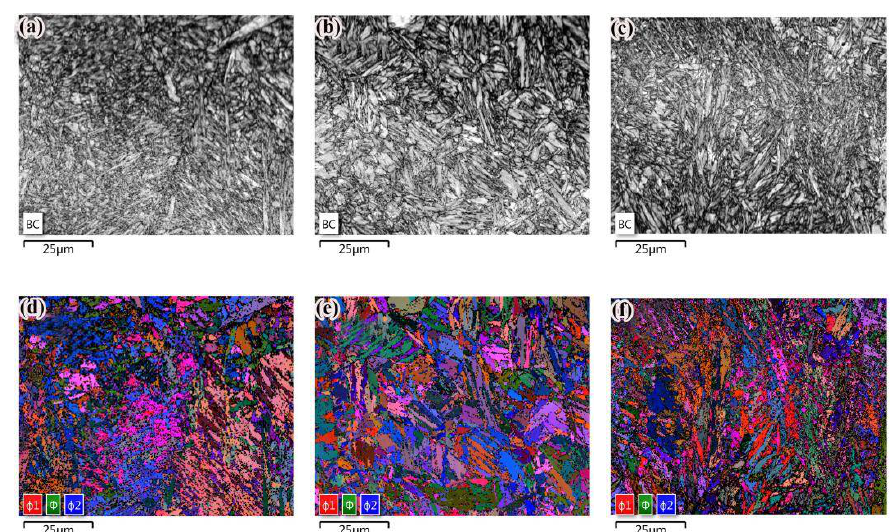
Figure 4. Analysis of phase electron backscattered scattering detection (EBSD): ( a – c ) represent the